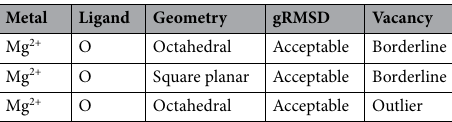
Table 2. Metal-binding site geometry